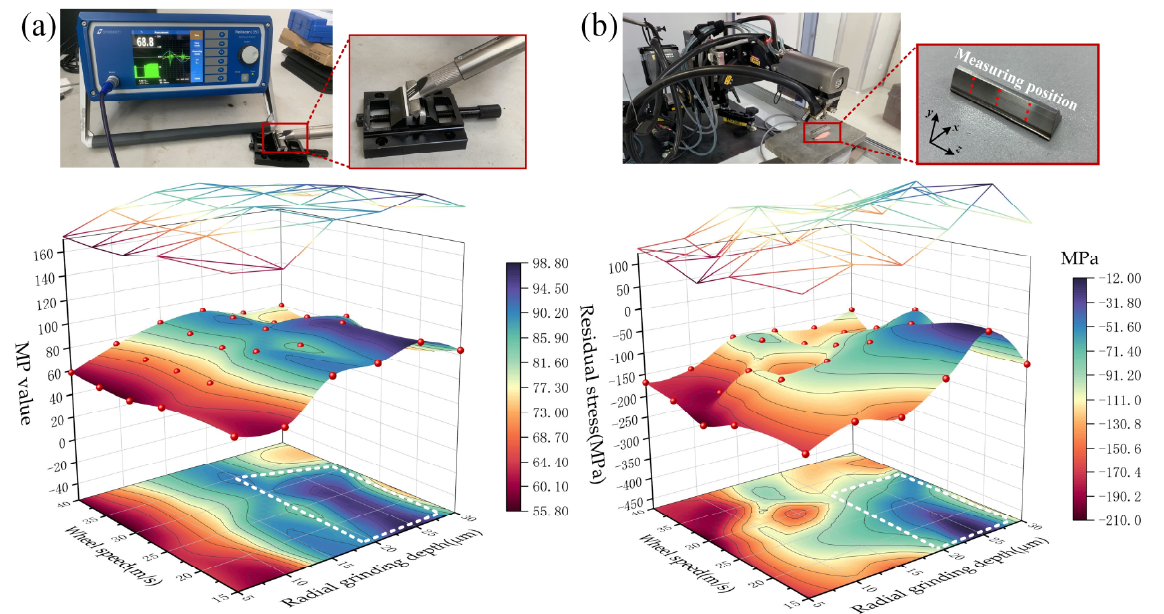
Figure 4. Testing and results: ( a ) Barkhausen noise test and results; ( b ) tooth flank residual stress test and results.